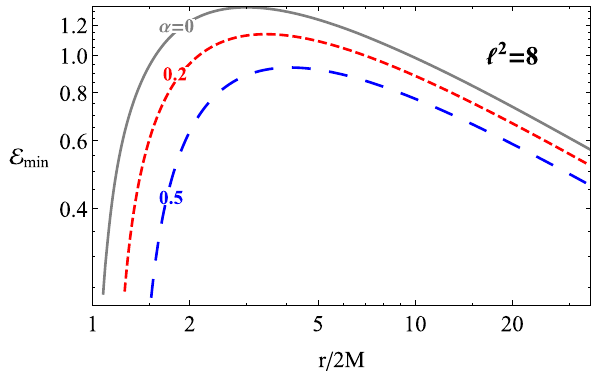
Fig. 2 The radial dependence of minimal energy of the magnetized particle for the different values of the α parameter